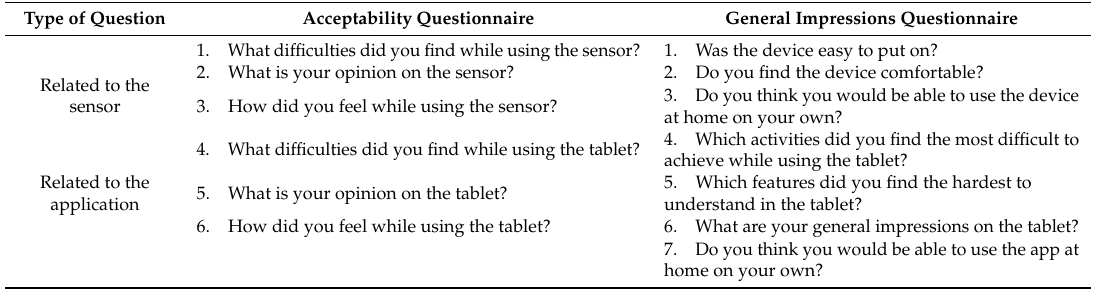
Table 2. List of questions in the acceptability and general impressions questionnaires. The first three questions in each questionnaire ask about the participant’s experience while using the sensor. Whereas, the remaining ones ask about the participant’s experience while using the home care application on the